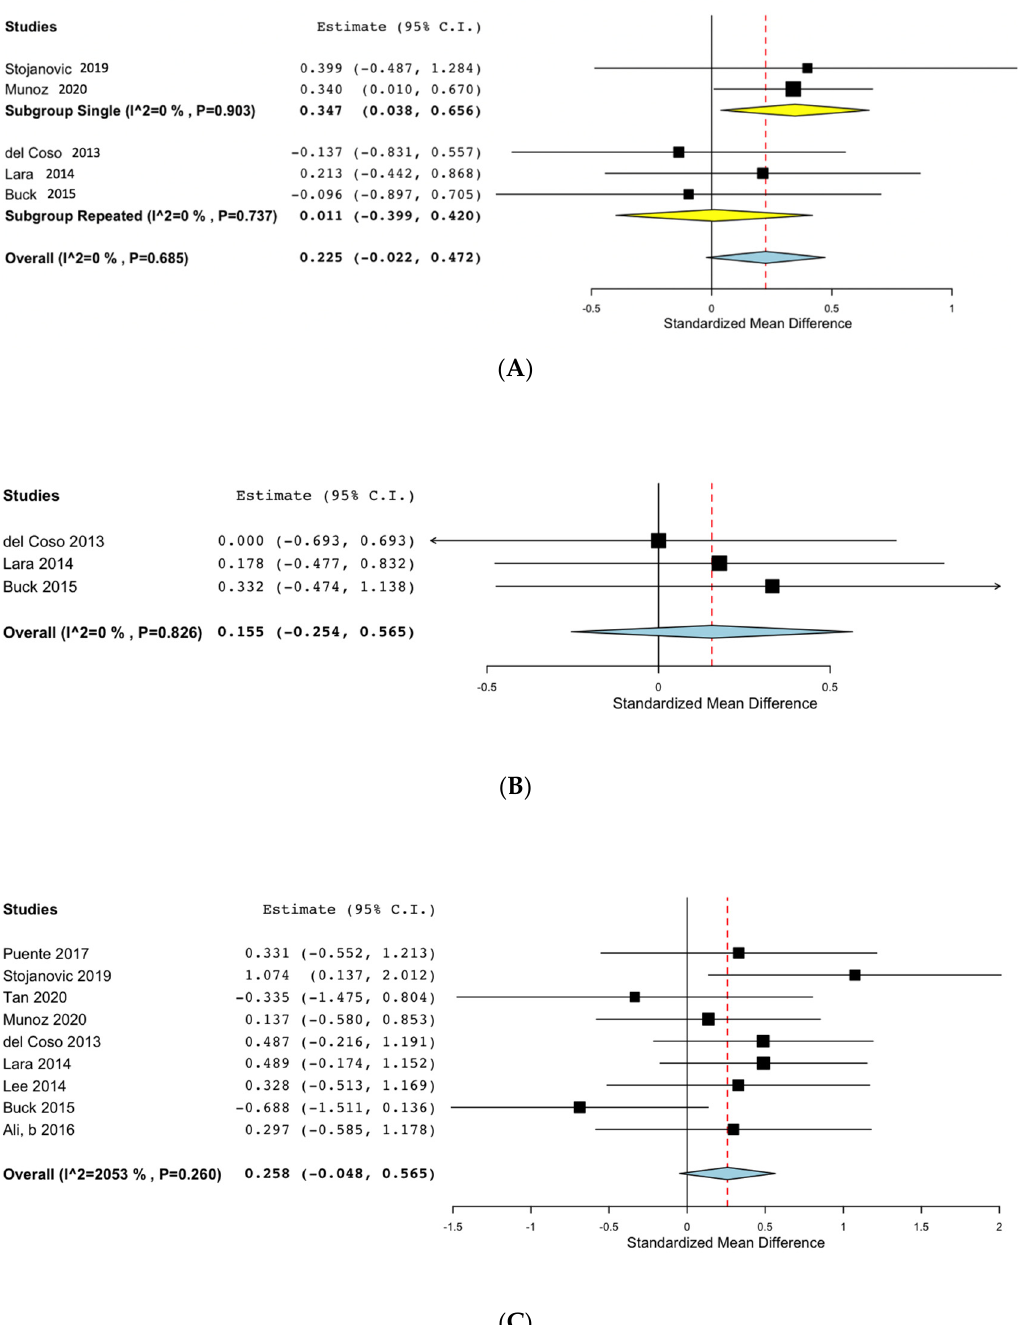
Figure 4. ( A ): Effects of caffeine on single sprint performance. ( B ): Effects of caffeine on repeated sprint ability performance. ( C ): Effects of caffeine on rate of perceived exertion.